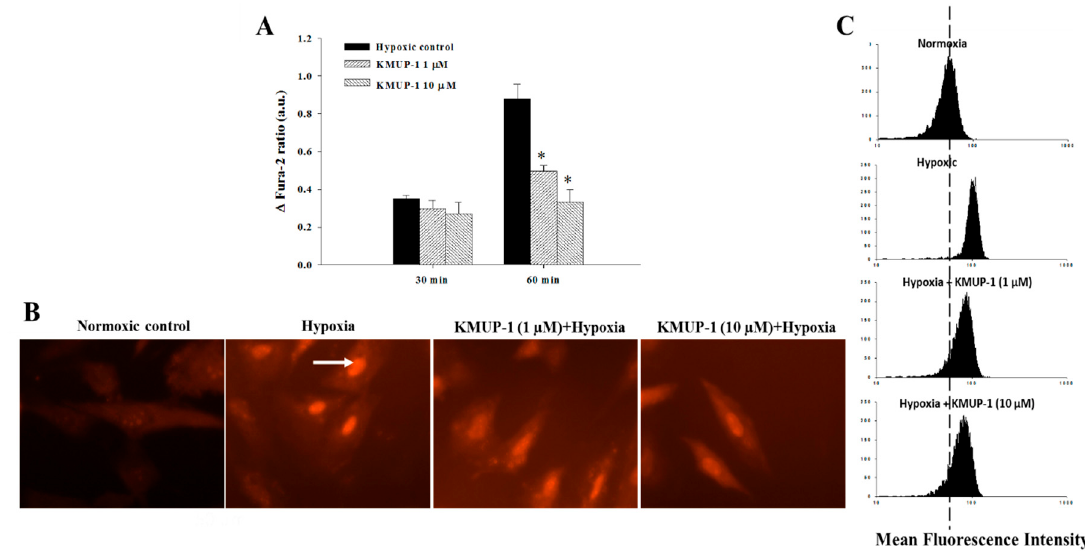
Figure 4. Evaluation of Ca 2 + concentration [Ca 2 + ] in H9c2 cardiomyoblasts. ( A ) A representative of intracellular Ca 2 + concentration ([Ca 2 + ]i) fluorescence intensity in H9c2 cells after 24 h KMUP-1 pretreatment and then incubated with hypoxia for 30 min and 60 min, respectively. Fura-2-AM labeling in H9c2 cells shows that KMUP-1 pretreatment (1 and 10 µ M) groups have lower [Ca 2 + ]i compared with both hypoxic control groups. ( B ) Mitochondrial Ca 2 + concentration ([Ca 2 + ]m) imaging with Rhod 2-AM. Fluorescence evaluation shows higher [Ca 2 + ]m in hypoxia group (white arrow). ( C ) Intracellular oxidant stress evaluation with 2’,7’-dichlorofluorescin diacetate (DCFH-DA) labeling in H9c2 cells to evaluate hydroxyl generation (H 2 O 2 ). Fluorescence photomicrograph shows an elevation of H 2 O 2 generation in hypoxia group compared with normoxia and KMUP-1 (1 and 10 µ M) pretreatment groups. All values were expressed as mean ± SEM, n = 6, * p < 0.05.